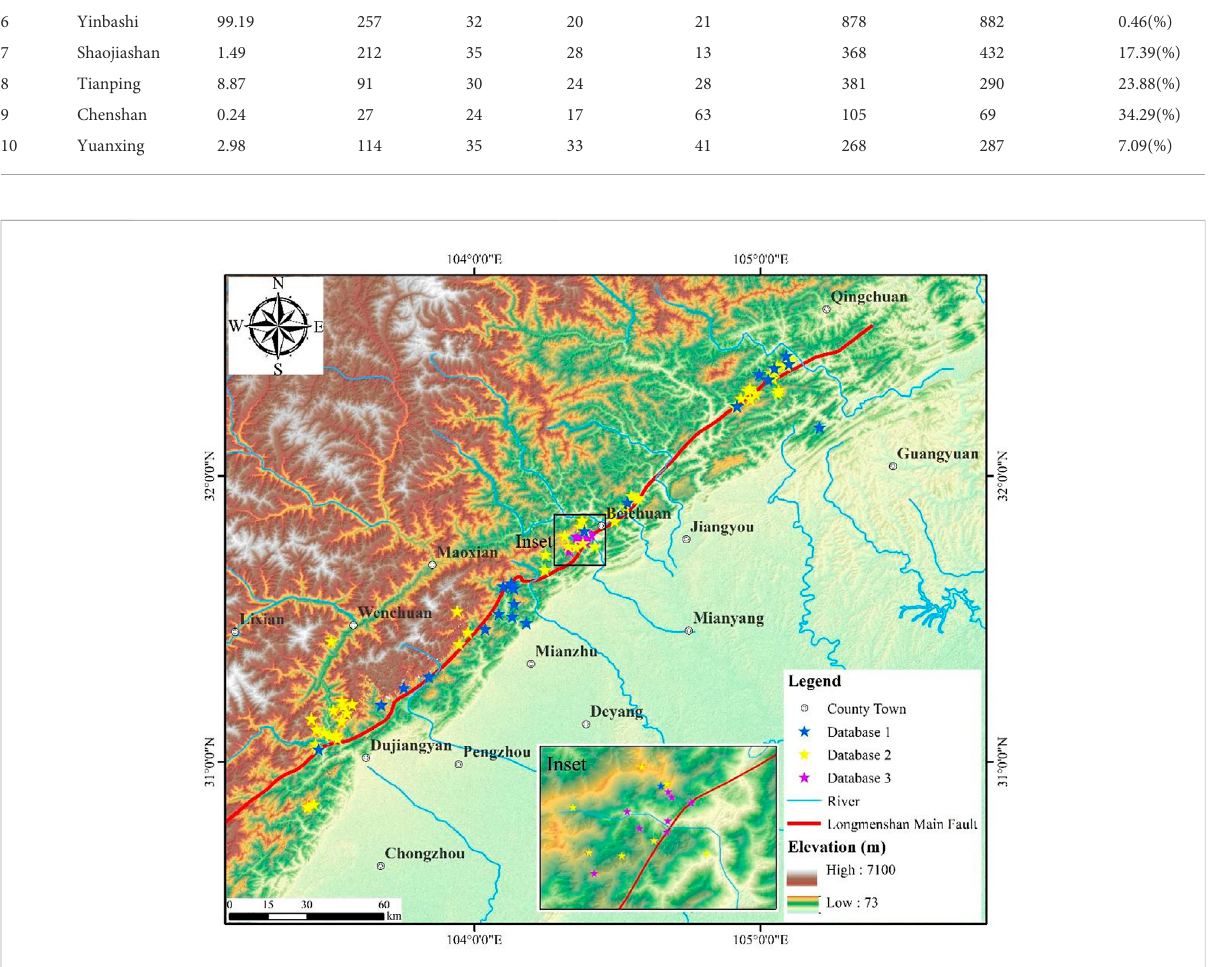
FIGURE 2 The locations of rock avalanches in the Wenchuan earthquake area collected in three